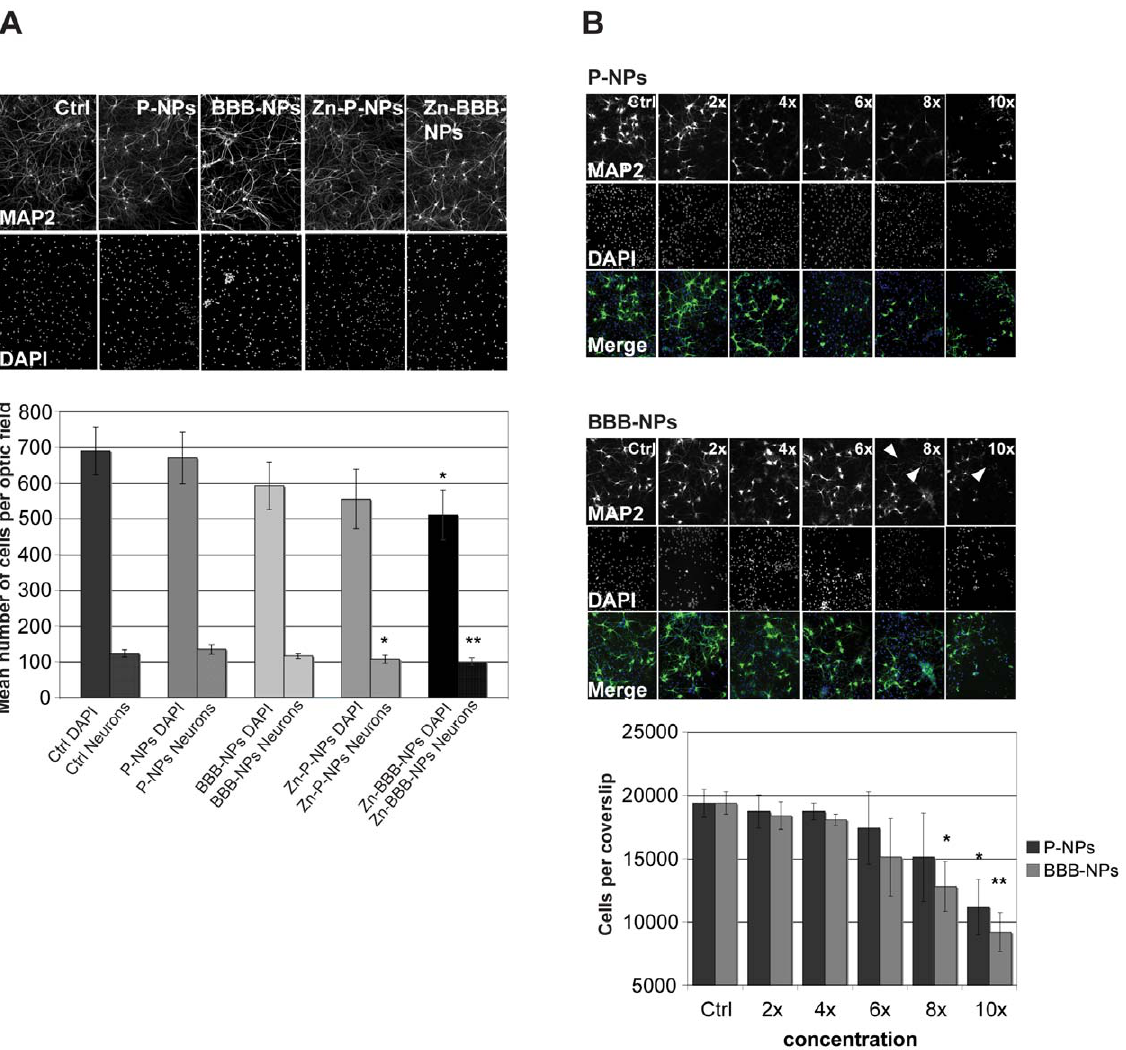
Figure 1. Cell viability after treatment with NPs. A) Mixed neuronal cultures containing glia cells and hippocampal neurons were plated and grown until DIV14. Cells were treated with the following NPs: ‘‘P-NPs’’ (empty NPs without ligand), ‘‘BBB-NPs’’ (un-loaded g7 ligand coated NPs), ‘‘Zn- P-NPs’’ (NPs encapsulating Zn 2 + ) or ‘‘Zn-BBB-NPs’’ (g7 ligand coated NPs encapsulating Zn 2 + ) (all: 625 m g NPs per ml), at DIV7. Upper panel: cells were stained with antibodies against the dendritic microtubule associated protein MAP2 and DAPI. The number of neurons (MAP2 positive cells) and the overall cell number (DAPI staining) per optic field was measured. Neither P-NPs nor BBB-NPs affected cell number as quantified in the lower panel. A small but significant reduction in cell number was observed in Zn-NPs (neurons) and Zn-BBB-NPs treated cells. B) Neuronal/glial cultures were plated at 20,000 cells per coverslip and treated for 7 days with different concentrations of P-NPs and BBB-NPs (e.g. multiples of 625 m g NPs per ml applied to control cells (Ctrl)). The cells were treated at 7DIV fixed at DIV14 and labeling for MAP2 and nuclei (DAPI) was performed. Lower panel: quantification of DAPI positive cells/optical field of view (40 6 mag). Only healthy nuclei were counted. At 10 6 625 m g/ml (6.25 mg/ml), there is a significant reduction in cell number of cells treated with P-NPs. Cell-number reduction with BBB-NPs treated cells is seen at 8 6 625 m g/ml (5 mg NP/ml). Arrows indicate neurons that underwent cell death.